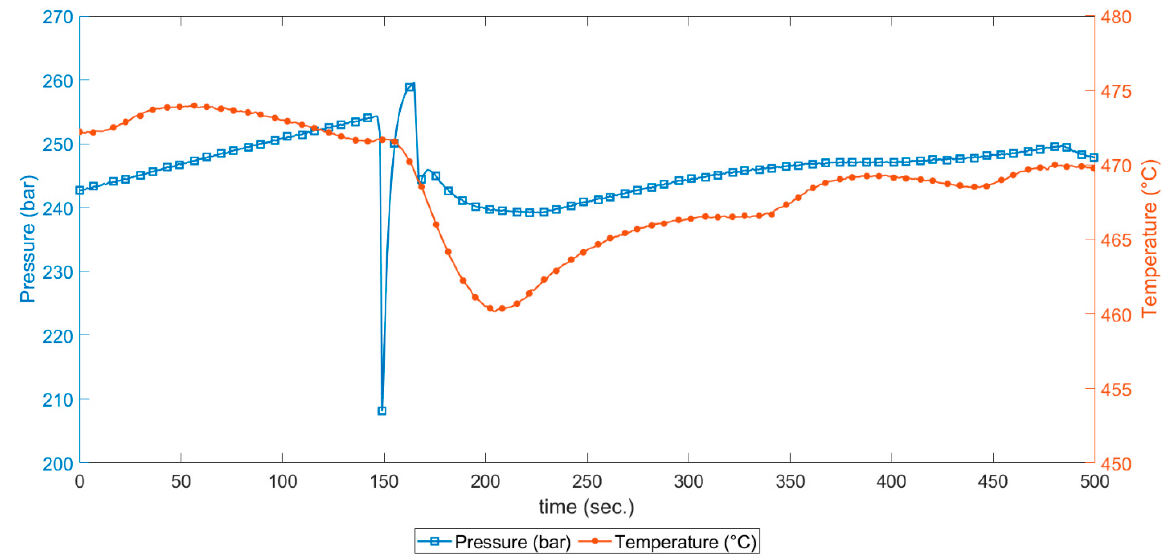
Figure 11. A more detailed representation of sudden pressure drops occurring during continuous operation and temperature recordings at the reactor inlet and outside wall.